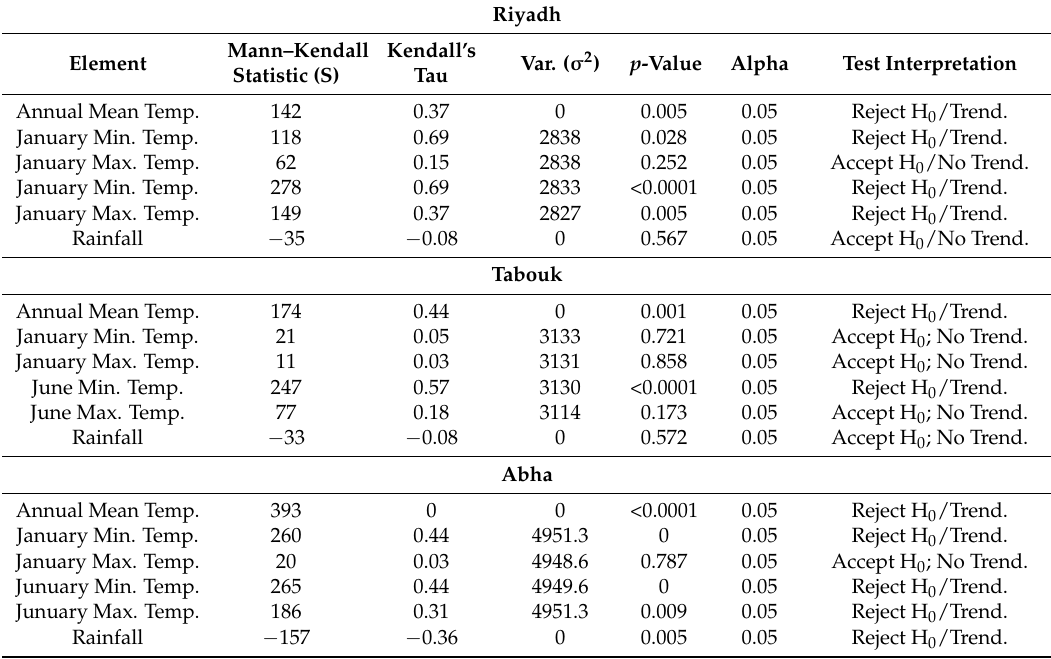
Table 3. Mann–Kendall trend analysis of temperature and rainfall for Riyadh, Tabouk and Abha representing the central, north and southwest regions of Saudi